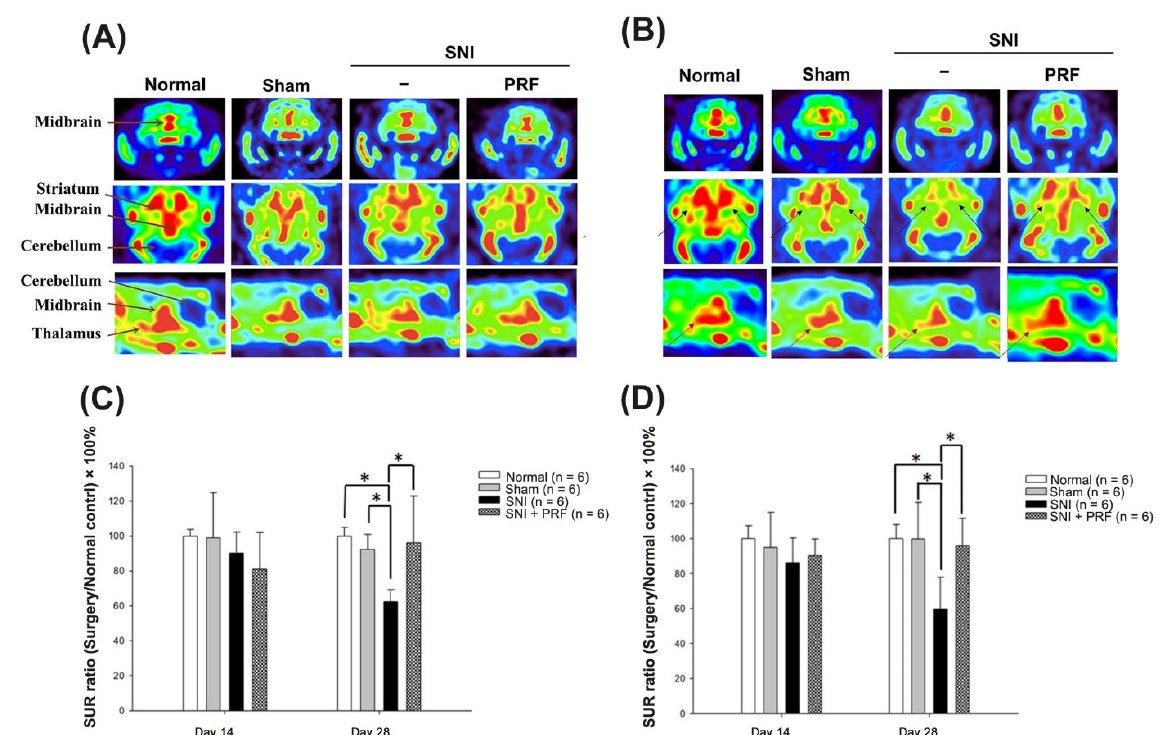
Figure 3. The4-[18F]-ADAM- micro-PET images and analysis of serotonin transporter levels via PET imaging. ( A ) 4-[18F]- ADAM- micro-PET images of coronal (top), transaxial (middle), and sagittal sections (bottom) of different rat brains on the 14th day after surgery. ( B ) 4-[18F]-ADAM- micro-PET images of coronal (top), transaxial (middle), and sagittal sections (bottom) of different rat brains on the 28th day after surgery. The black arrow indicates significant changes in the striatum region, and the red arrow indicates significant changes in the thalamus region. ( C ) The uptake of 4-[18F]-ADAM expressed by specific uptake ratios (SURs) was used to compare SERT levels of the striatum in the normal control, sham, SNI, and SNI + PRF groups on days 14 and 28. * p < 0.05, normal control, sham and SNI + PRF compared with the SNI group. ( D ) The uptake of 4-[18F]-ADAM expressed by SURs was used to compare SERT levels of the thalamus in the normal control, sham, SNI, and SNI+PRF groups on days 14 and 28. * p < 0.05, normal control, sham, and SNI + PRF compared with the SNI group.